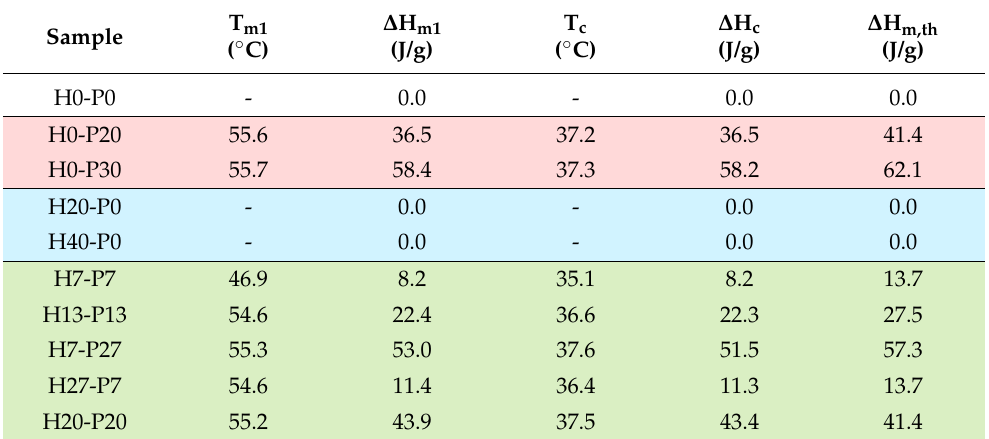
Figure 6. ( a ) Representative DSC thermograms of the prepared foams (first heating scan), ( b ) ternary diagram of the melting enthalpy values (first heating scan). Table 3. DSC results of the first heating and cooling scans of the prepared foams. The final column shows the theoretical melting enthalpy (ΔH m,th ), referred to the nominal PCM content in the foams.